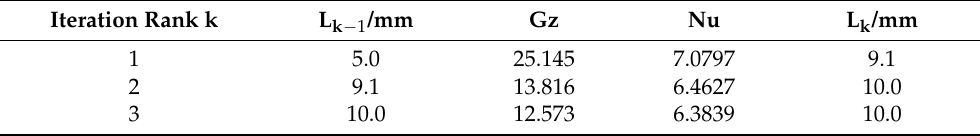
Table 4. Results obtained over the iterative calculation procedure yielding to the wanted length L value of the fast-quenching